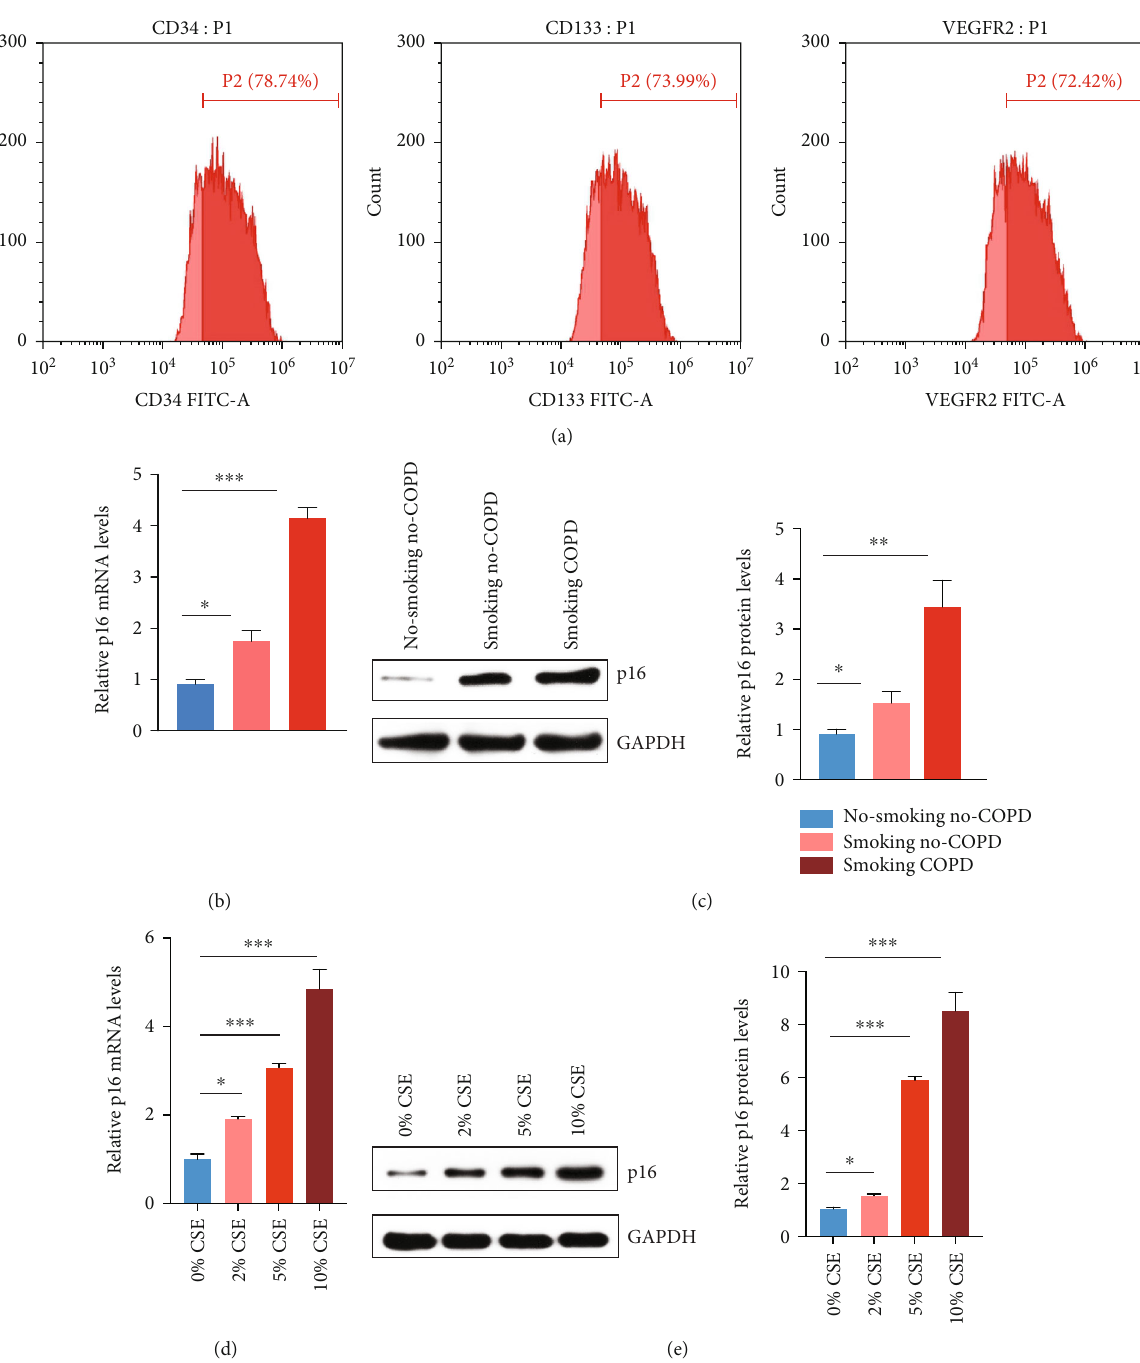
Figure 1: High expression of p16 in EPCs of COPD patients. (a) Peripheral blood EPCs were isolated from nonsmoking non-COPD patients. Flow cytometry veri fi ed that the isolated cells were peripheral blood endothelial cells. (b) RT-PCR was used to detect the expression of p16 in peripheral blood EPCs of nonsmoking non-COPD, smoking non-COPD, and smoking COPD patients. (c) Western Blot was used to detect the expression of p16 in peripheral blood EPCs of nonsmoking non-COPD, smoking non-COPD, and smoking COPD patients setting each group with 20 samples. (d) Peripheral blood EPCs from nonsmoking non-COPD patients were treated with di ff erent concentrations of CSE, and the expression of p16 was detected by RT-PCR. (e) Peripheral blood EPCs from nonsmoking non-COPD patients were treated with di ff erent concentrations of CSE, and the expression of p16 was detected by Western Blot. ∗ p < 0 : 05 , ∗∗ p < 0 : 01 , and ∗∗∗ p < 0 : 001